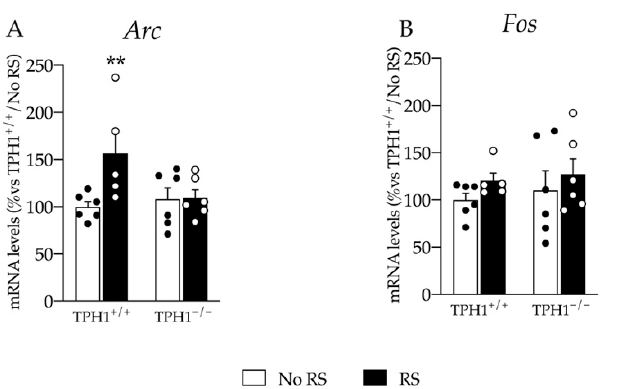
Figure 6. Analyses of Arc ( A ) and Fos ( B ) mRNA levels in the PFC of TPH1 +/+ and TPH1 − / − male adult rats exposed to RS and sacrificed immediately after stress. The data, expressed as a percentage of TPH1 +/+ /No RS (set at 100%), are the mean ± standard error of the mean (SEM) of at least 5 independent determinations. ** p < 0.01 vs. naïve for the same genotype; two-way ANOVA with Fisher’s PLSD.